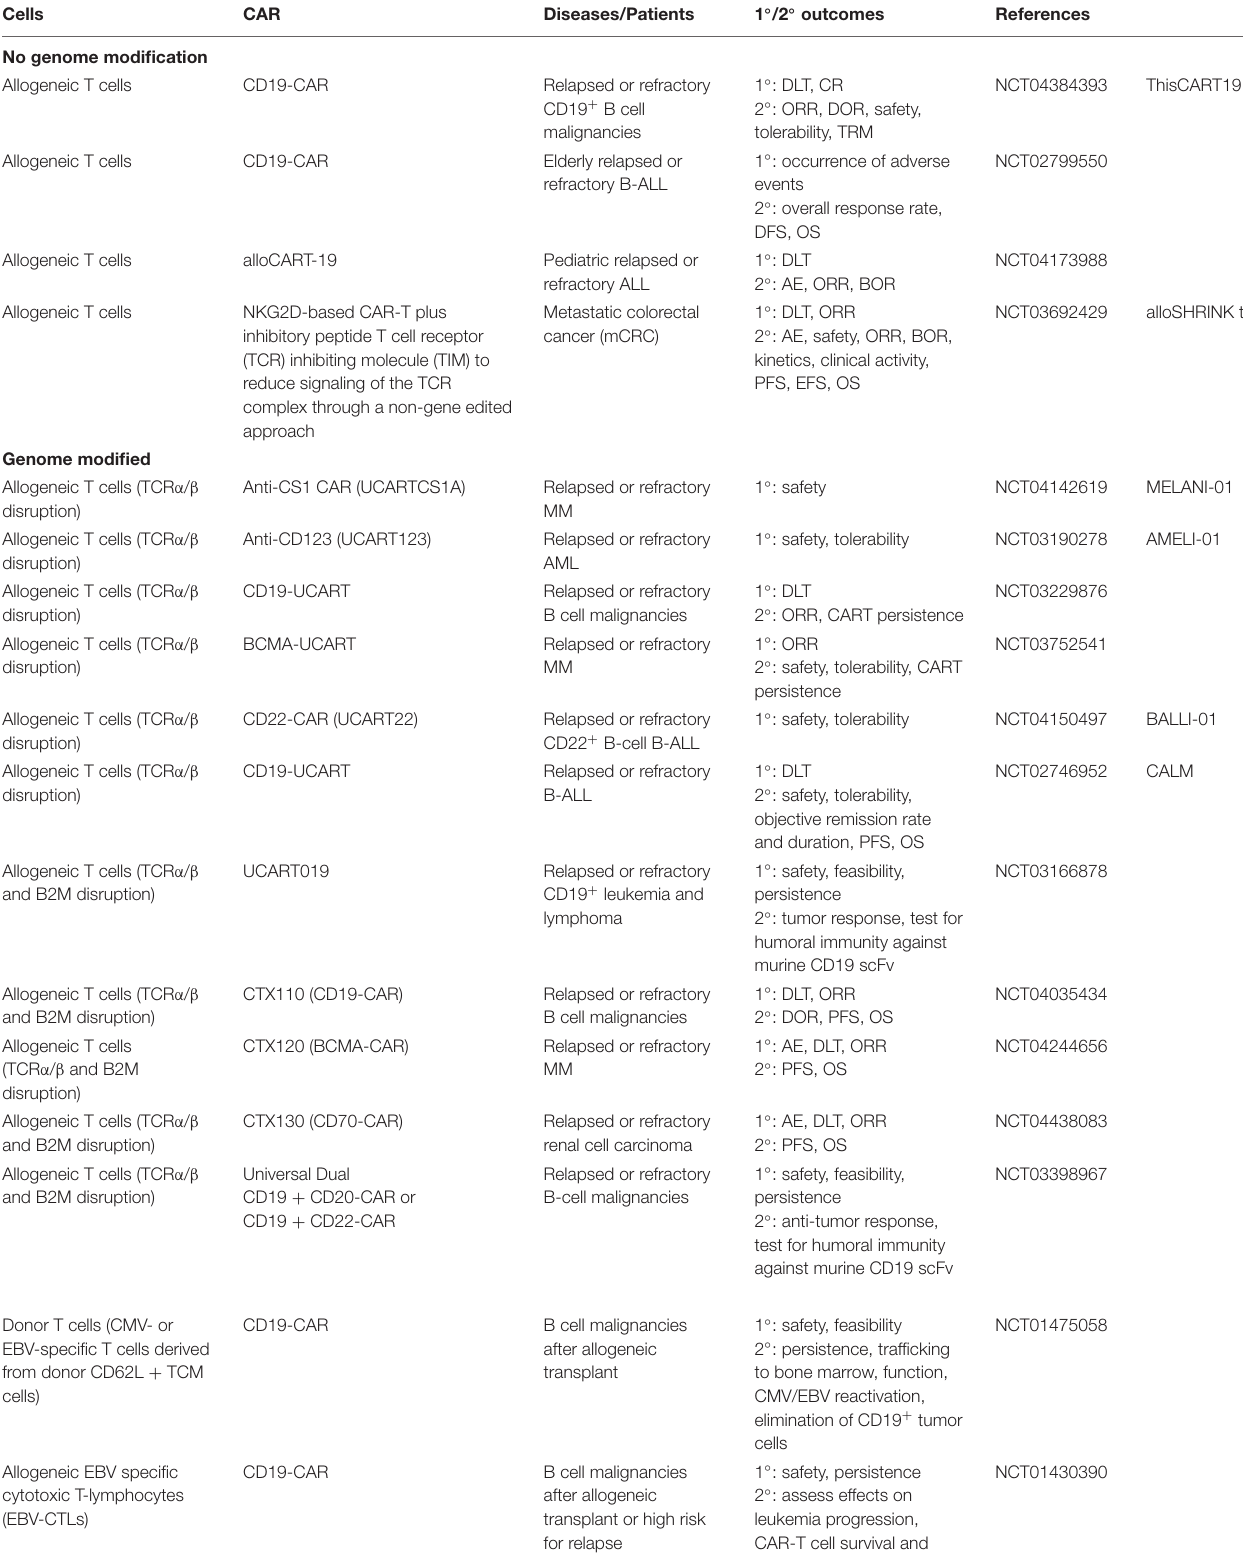
TABLE 1 | Selected clinical trials testing potential “off-the-shelf” CAR cell therapies.